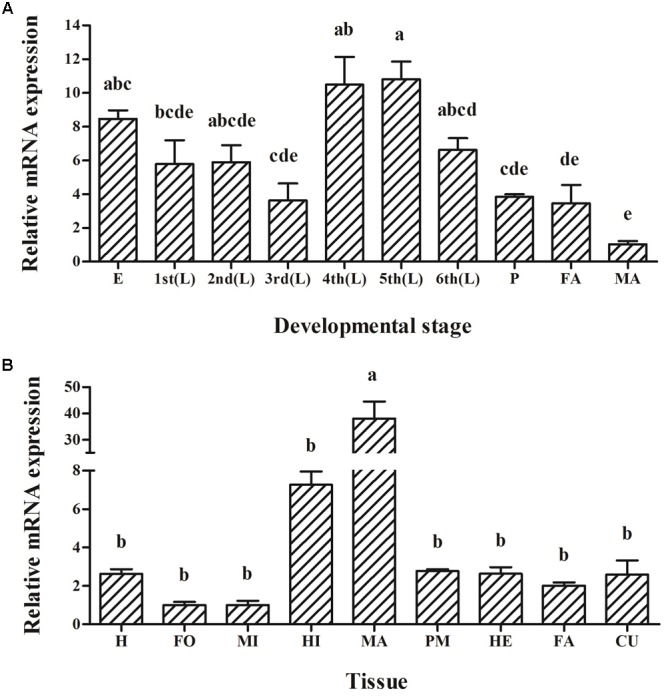
Expression of the HaABCC1 gene in different developmental stages and tissues of H. armigera larvae as determined by a RT-qPCR analysis. (A) Relative expression levels of HaABCC1 in eggs (E), first-instar larvae (1st), second-instar larvae (2nd), third-instar larvae (3rd), fourth-instar larvae (4th), fifth-instar larvae (5th), sixth-instar larvae (6th), pupae (P), female adults (FA), and male adults (MA). (B) Relative expression levels of HaABCC1 in head (H), foregut (FO), midgut (MI), hindgut (HI), Malpighian tubule (MA), peritrophic membrane (PM), hemolymph (HE), fat body (FA), and cuticle (CU) from fifth-instar larvae. Values shown are means and standard errors. Different letters indicate significant expression differences among different tissues or developmental stages based on three biological replications and four technical repeats (p < 0.05).